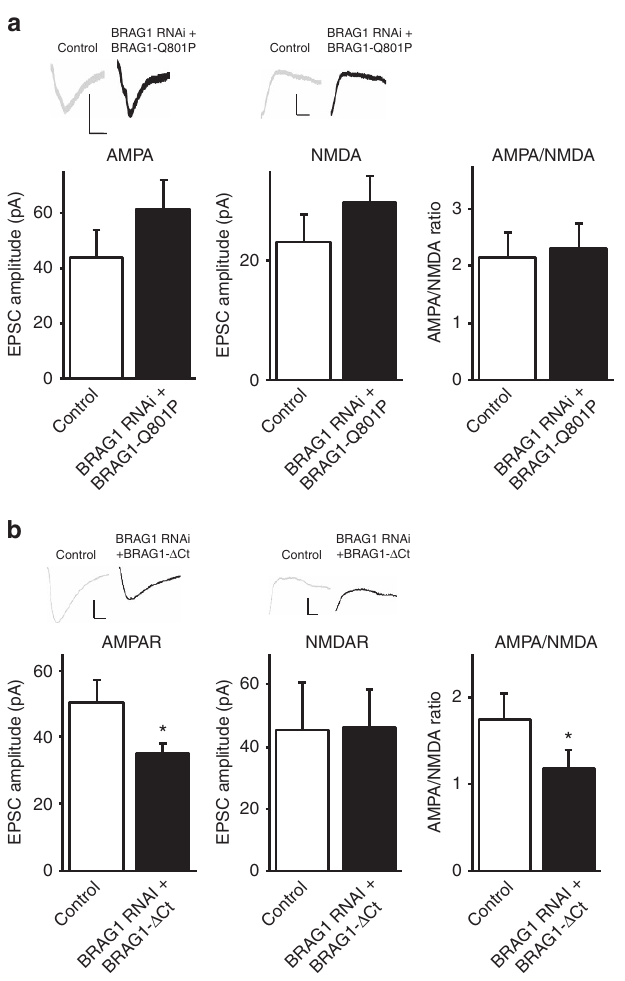
Figure 8 | BRAG1–PDZ-binding sequence, but not its Arf-GEF enzymatic activity, is required for the maintenance of synaptic transmission. ( a , b ) Left: sample traces of AMPAR- and NMDAR-mediated responses recorded at (cid:2) 60 and þ 40mv, respectively. Scale bars, 20pA, 20ms. Data represent averaged evoked EPSCs recorded for AMPA (left graphs), NMDA (centre graphs) and AMPA/NMDA ratios (right graphs) simultaneously from pairs of untransfected (control) CA1 neurons and neurons transfected with BRAG1 RNAi þ BRAG1-Q801P ( a ) or BRAG1 RNAi þ BRAG1- D Ct ( b ). * Indicates significance ( P r 0.05).